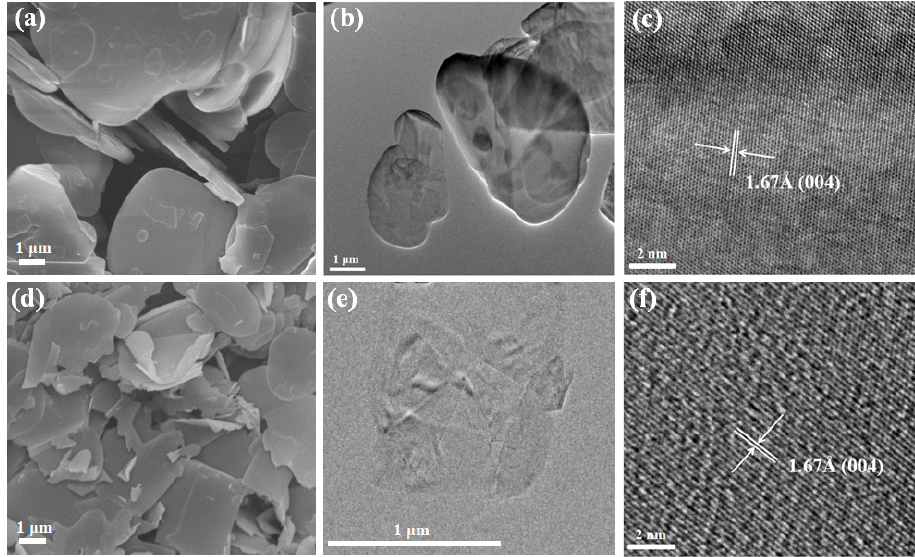
Figure 3. SEM images of ( a ) h-BN and ( d ) FL-hBN; TEM images of ( b ) h-BN and ( e ) FL-hBN; HR-TEM images of ( c ) h-BN and ( f ) FL-hBN. The insets show the selected area electron diffraction patterns.